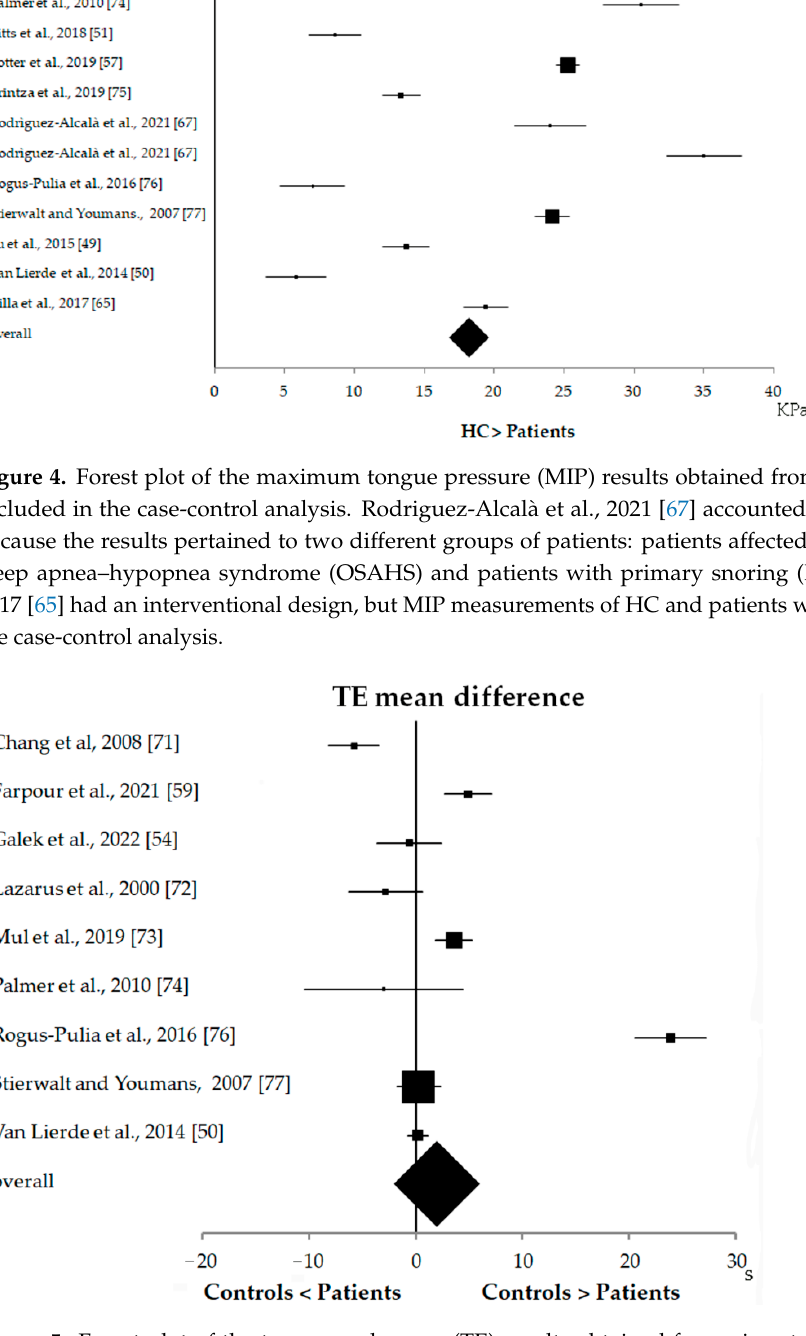
Figure 5. Forest plot of the tongue endurance (TE) results obtained from nine studies with case- control design.